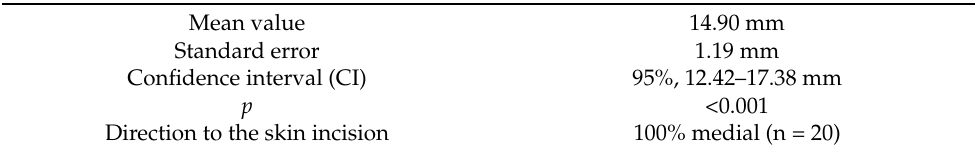
Table 1. Statistical analysis of the measurements concerning the distance of the nerve’s main trunk to skin incision on the left side.